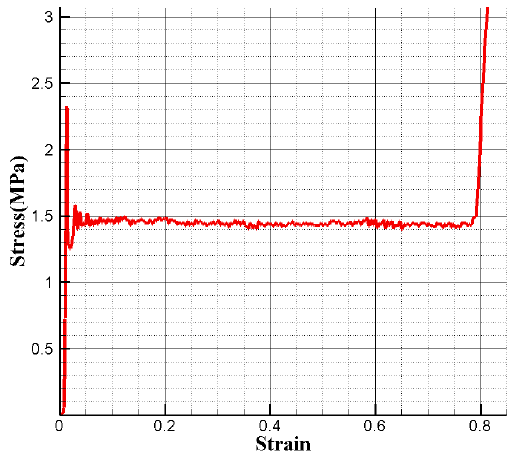
Figure 15. Stress–strain curve of Quasi-static compression test.